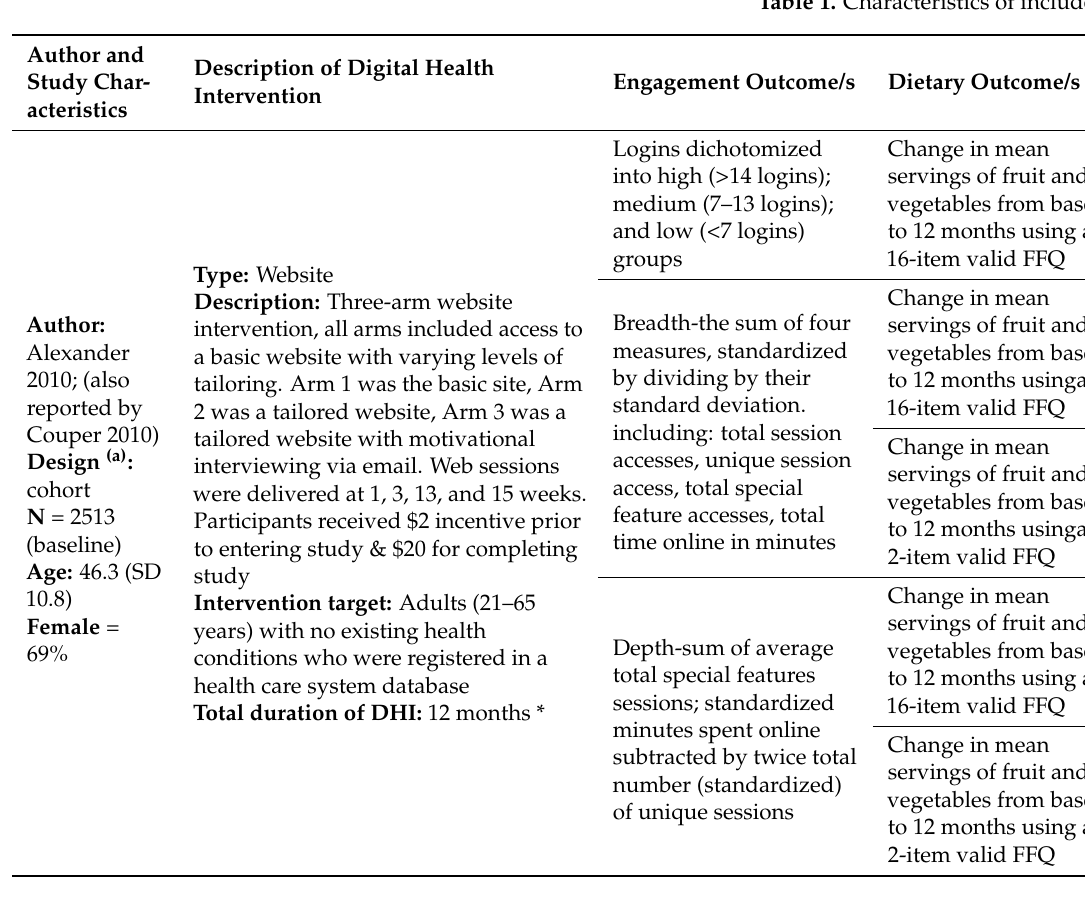
Table 1. Characteristics of included